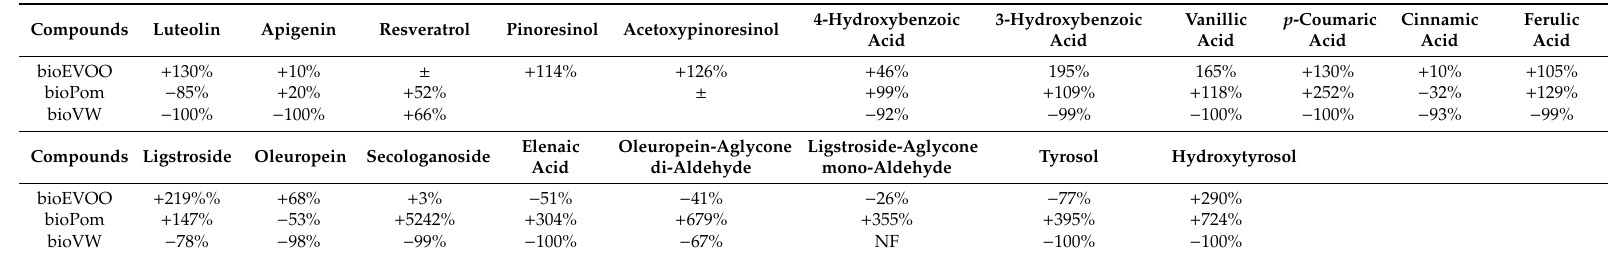
Table 6. Variation % of the concentration of each phenolic under